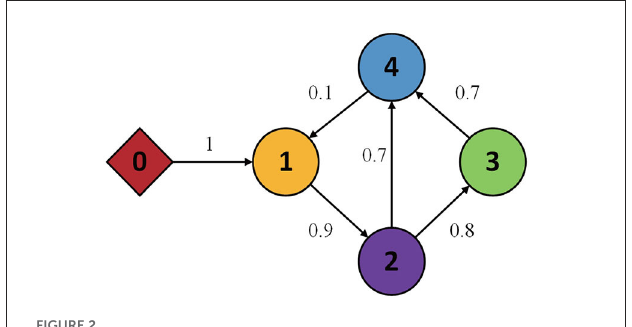
FIGURE2 Topology of communication